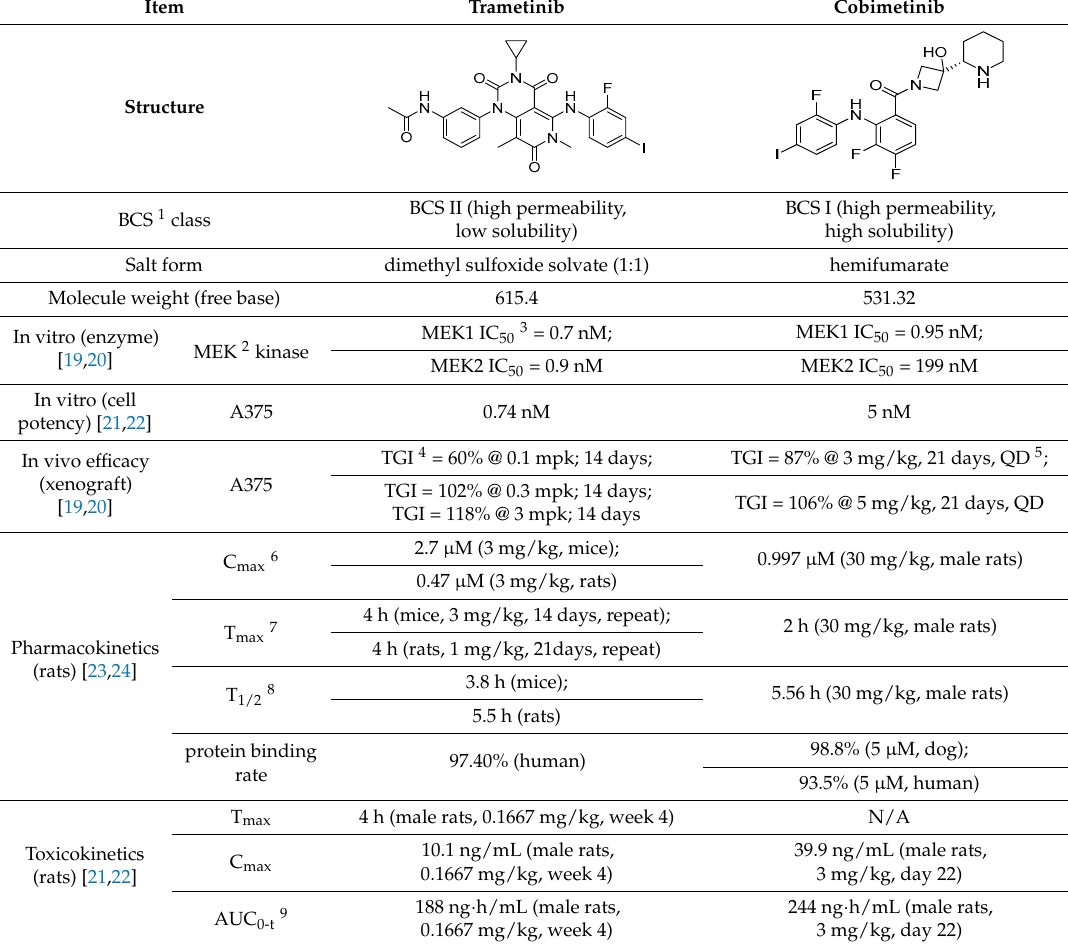
Table 1. Preclinical and clinical data for trametinib and cobimetinib.